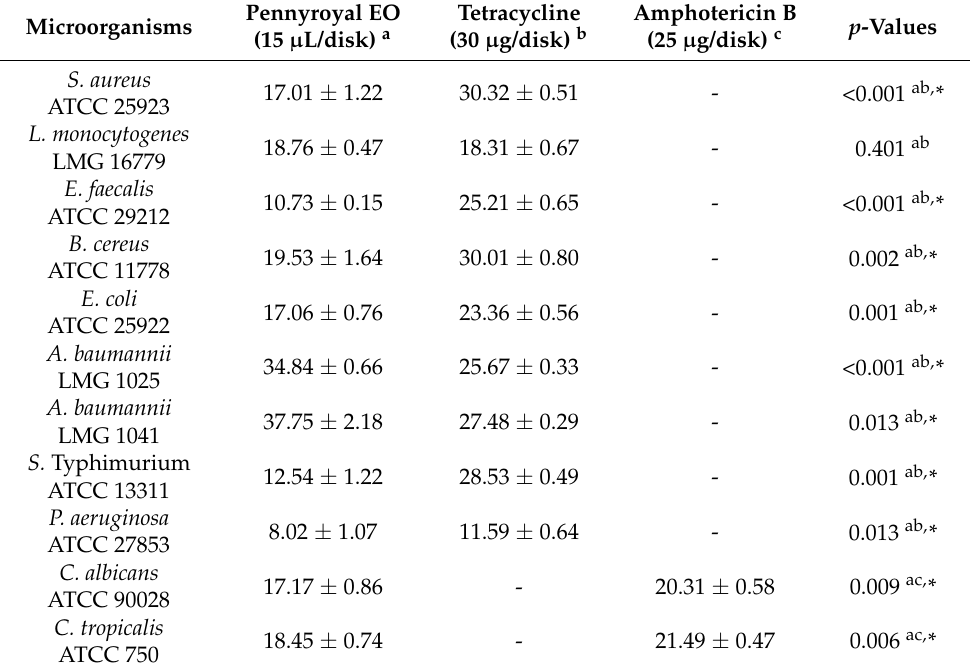
Table 3. Diameters of inhibition zones (mm), including the disk diameter (6